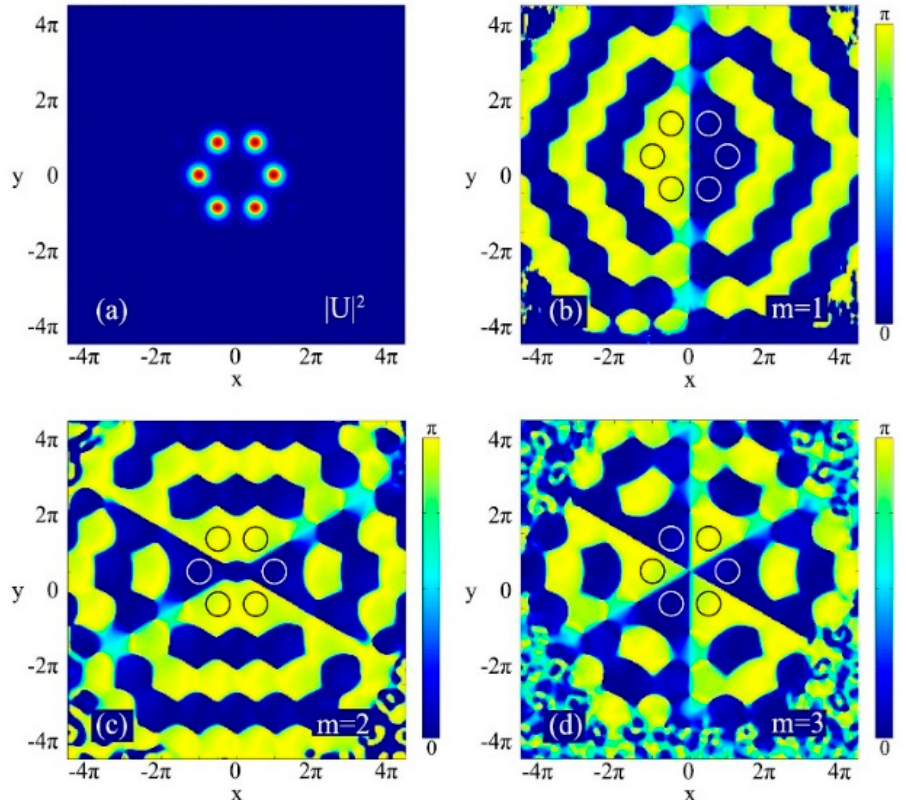
Figure 10. The profile and the phase structures of vortex solitons with different topological charges. ( a ) is their profile | U | 2 , i.e., square of modules of soliton solution U . ( b – d ) correspond to the phase structures of vortex solitons with m = 1,2,3. m = topological charges.